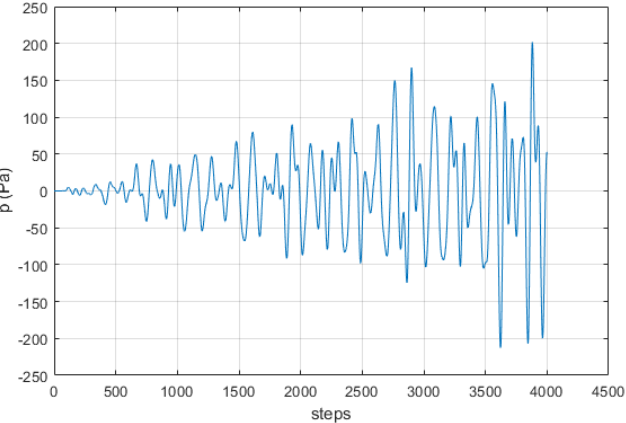
Figure 7. Backward step pressure time history, at the point of the novelty on the horizontal beam.